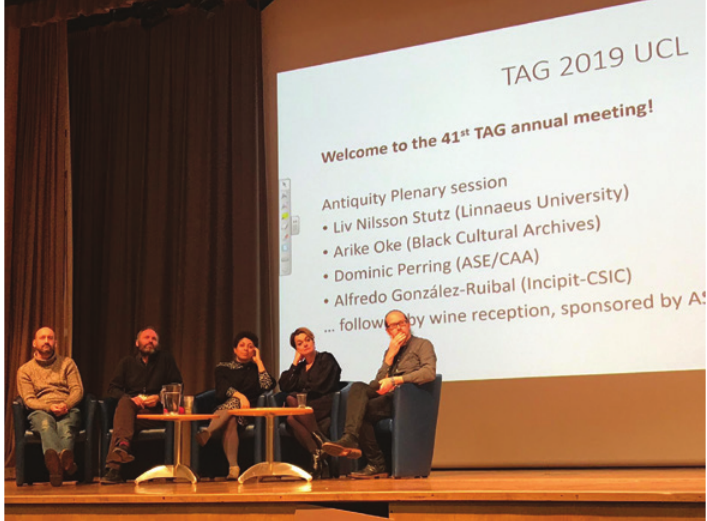
Figure 3 The plenary session. (Image credit: Andrew Gardner and Edith